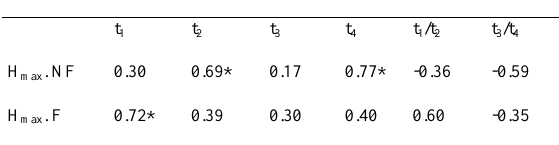
of the jumps max